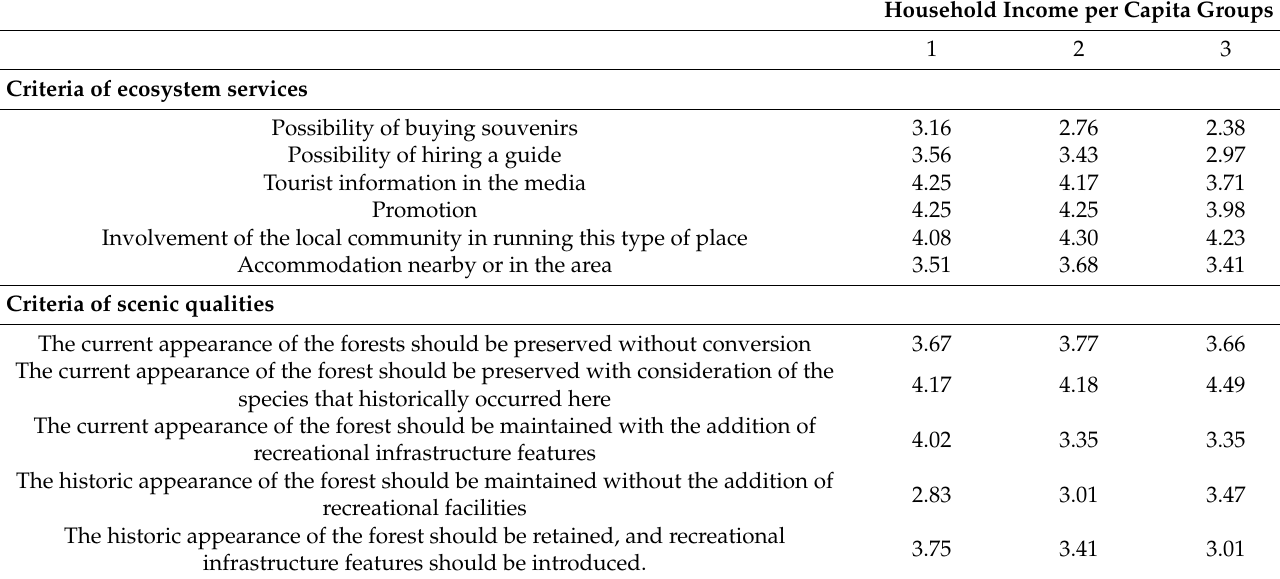
Table 3. An average score of the selected criteria of ecosystem services and the criteria of scenic qualities by visitor income (ranging from 1 to 5).